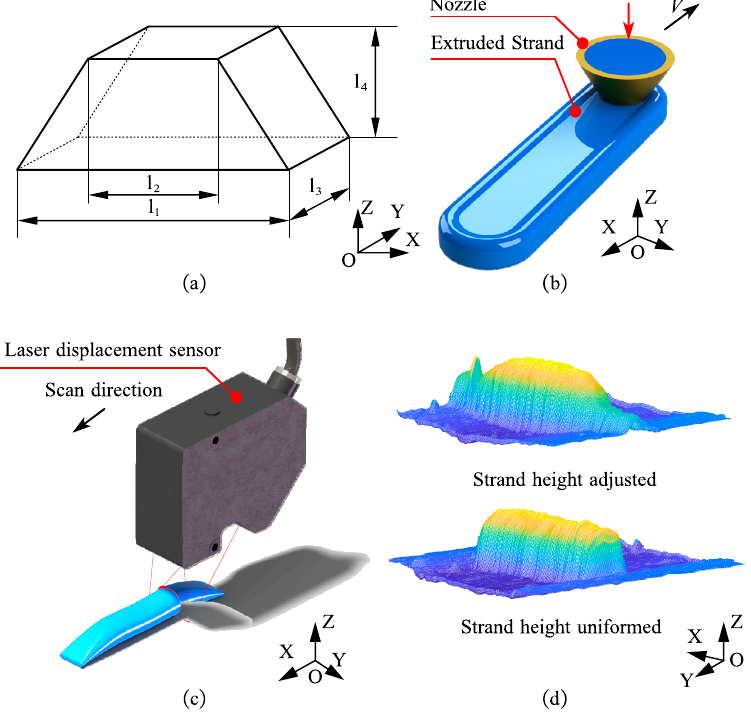
Figure 8. Schematic diagram of specimen fabrication and profile scanning with adjustable strand height. ( a ) 3D model of the specimen, where l1 = 60 mm, l2 = 20 mm, l3 = 1.0 mm, l4 = 0.8 mm; ( b ) schematic diagrams of the specimen fabrication process; ( c ) profile scanning process, where the data of each profile scan consist of 800 height measurements distributed along the Y-axis, and the laser